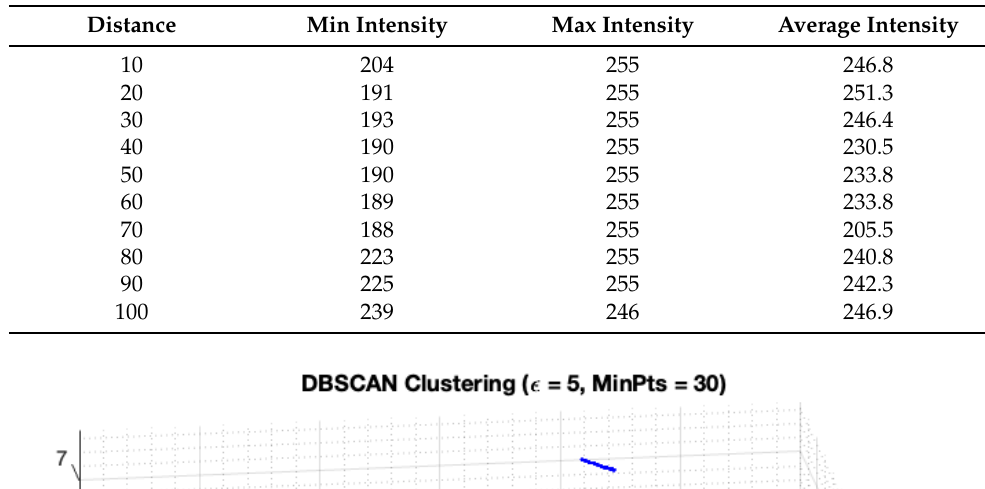
Table 2. Intensity at different distances.